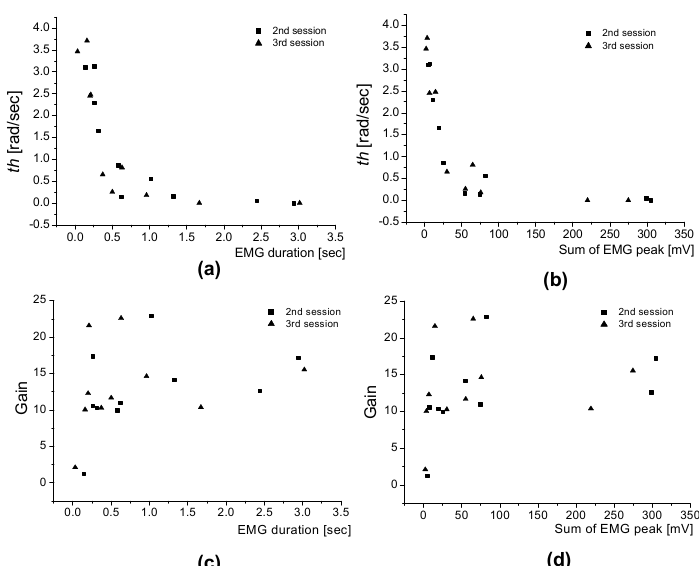
Fig.6. The relationship between the identified threshold and the EMG duration (a) and the peaks sum (b) and between gain and EMG duration (c) and peaks sum (d). The EMG duration and peaks sum values are the mean of each session. Thresholds show a tendency to decrease with EMG duration and peaks sum, but there was no trend in